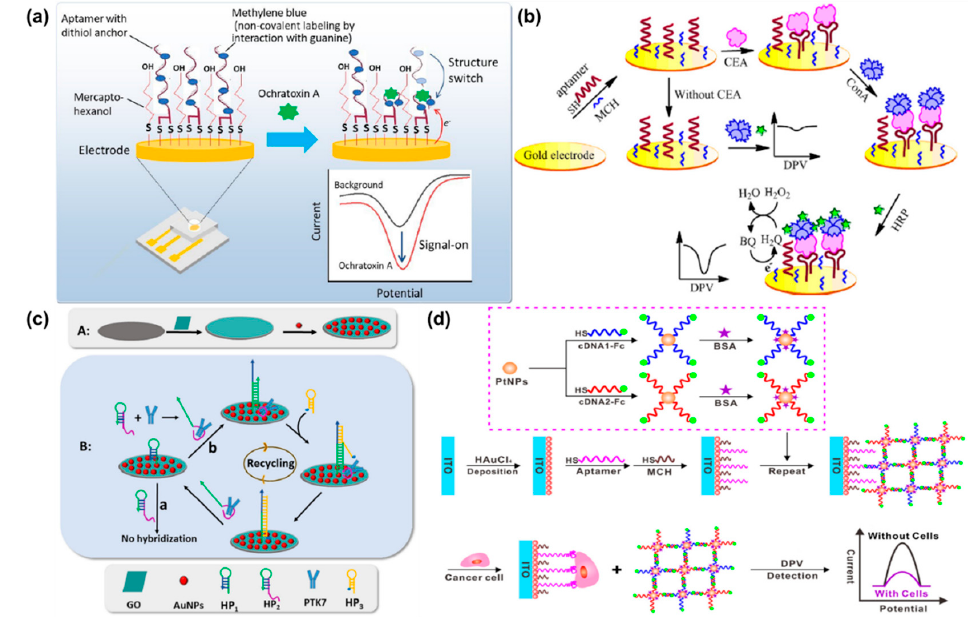
Figure 6. Electrochemical aptasensors for the detection of biomolecules. ( a ) Aptamer anchored on gold electrode surface for Ochratoxin A (OHA) detection through structure switching of the aptamer [88]. ( b ) ECB for the sensitive detection of carcinoembryonic antigen (CEA) through label-free sandwich method [89]. ( c ) Aptamer displacement strategy-based sensor for the detection of PTK-7 [93]. ( d ) Schematics of a label-free competitive aptamer cytosensor design and detection process